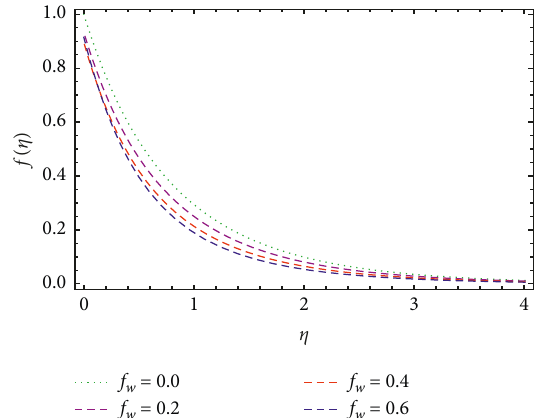
Figure 13: The influence of the temperature profile for different values of a ∗ ,b ∗ , when K � 0 . 1 , β � 0 . 4 , Pr � 5 . 0 ,E c � 0 . 4 , λ � 0 . 2 , and f w � 0 . 3 .